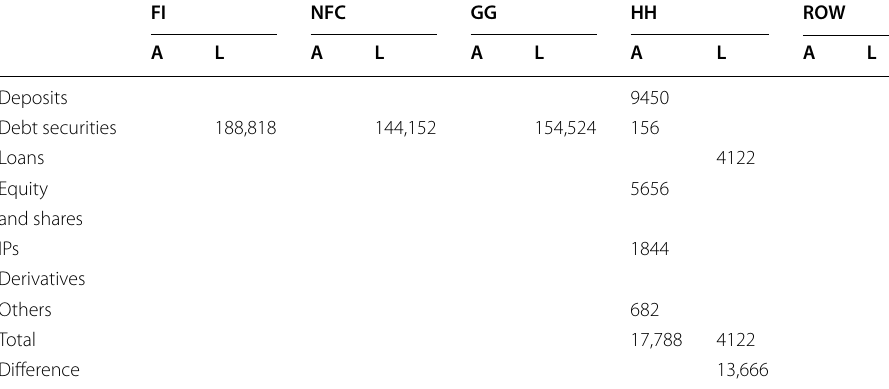
Table 7 Estimation of HHs and debt securities (in units of 100 million